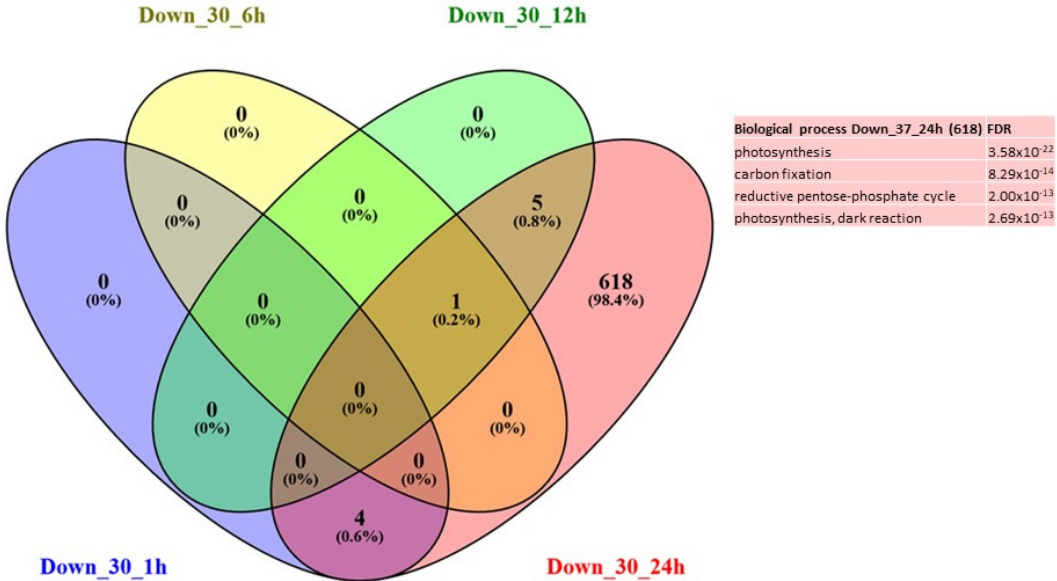
Figure 4. Venn diagram of expression data analysis at 30 °C of the down-regulated genes at 1 h, 6 h, 12 h and 24 h; and associated GO terms. Down_30_1h = down-regulated DEG at 30 °C at 1 h, Down _30_6h = down-regulated DEG at 30 °C at 6 h, Down _30_12h = down-regulated DEG at 37°C at 12h, Down _30_24h = down-regulated DEG at 30 °C at 24 h.